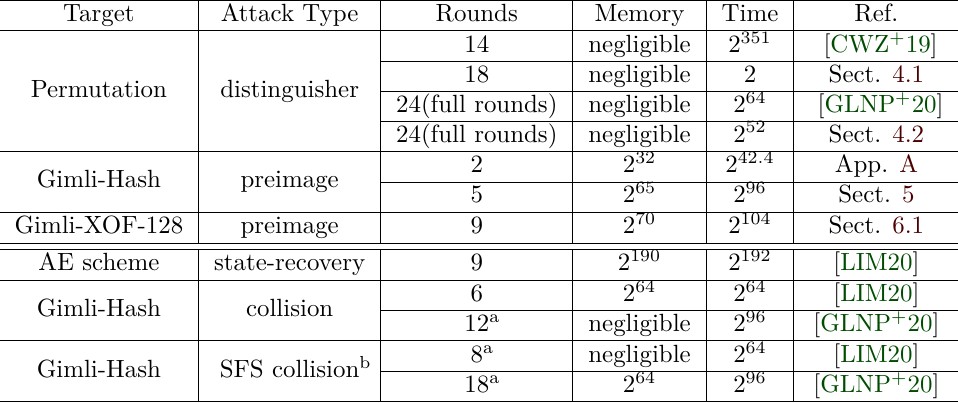
Table 1: The analytical results of Gimli, where the attacks in the quantum setting are